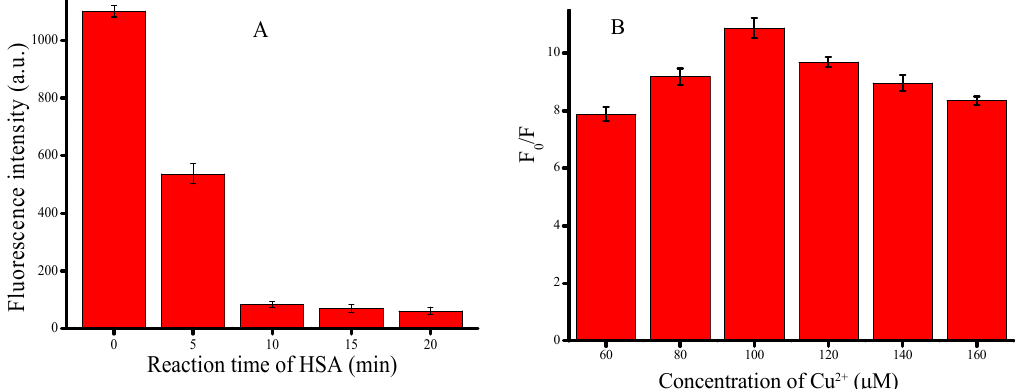
Figure 2. Optimization of experimental conditions. ( A ) Changes in fluorescence intensity with reaction time of HSA (0, 5, 10, 15, 20 min); ( B ) Changes in fluorescence intensity with different concentrations of CuSO 4 (60, 80, 100, 120, 140, 160 µM). Error bars were estimated from three replicate measurements.